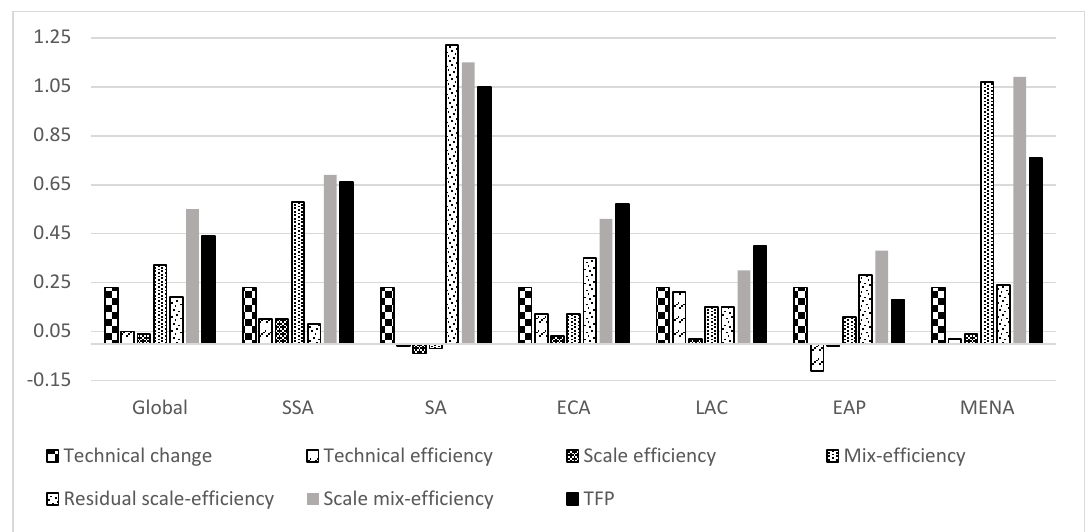
Figure 5. Growth rate (%) of TFP and its components.